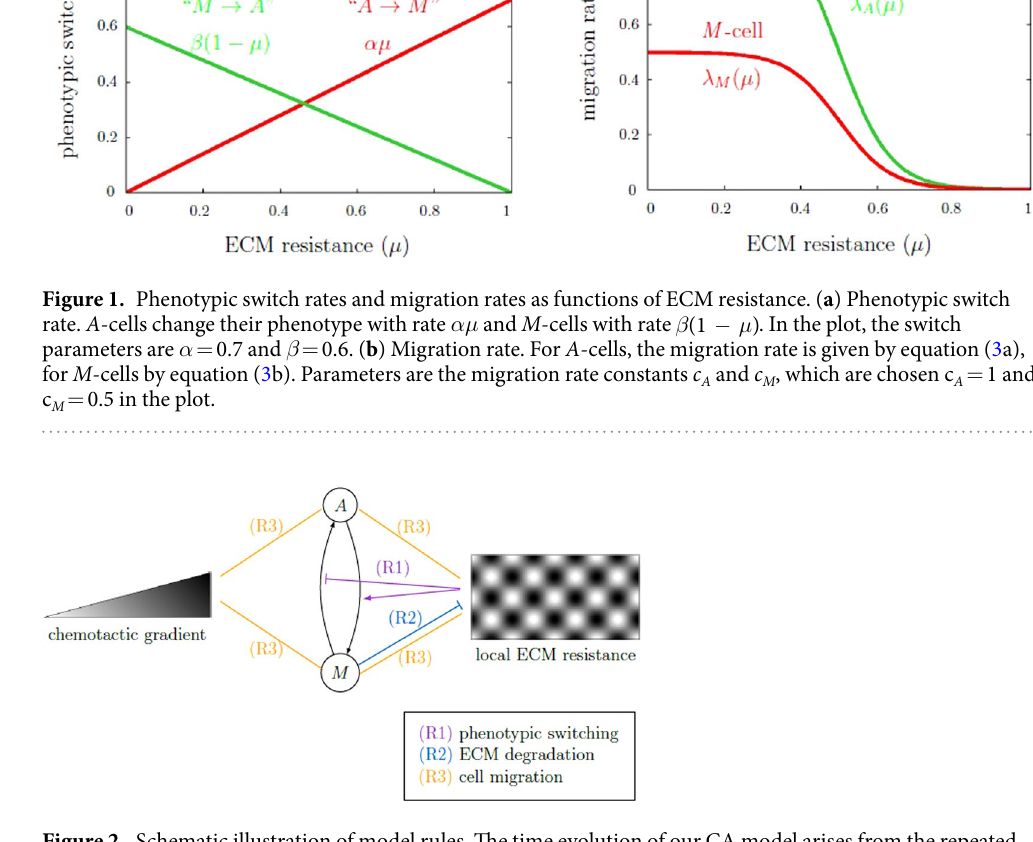
Figure 2. Schematic illustration of model rules. The time evolution of our CA model arises from the repeated application of three rules: (R1) phenotypic switching between A - and M -cells depending on ECM resistance, (R2) ECM degradation by M -cells and (R3) cell migration depending on the ECM resistance, preferentially in direction of the chemotactic gradient. The black arrows indicate the switch ability between A - and M -cells. Relations between chemotactic gradient, A / M -cells and local ECM resistance are indicated by arrows (positive influence), stopped lines (negative influence) and straight lines (positive or negative